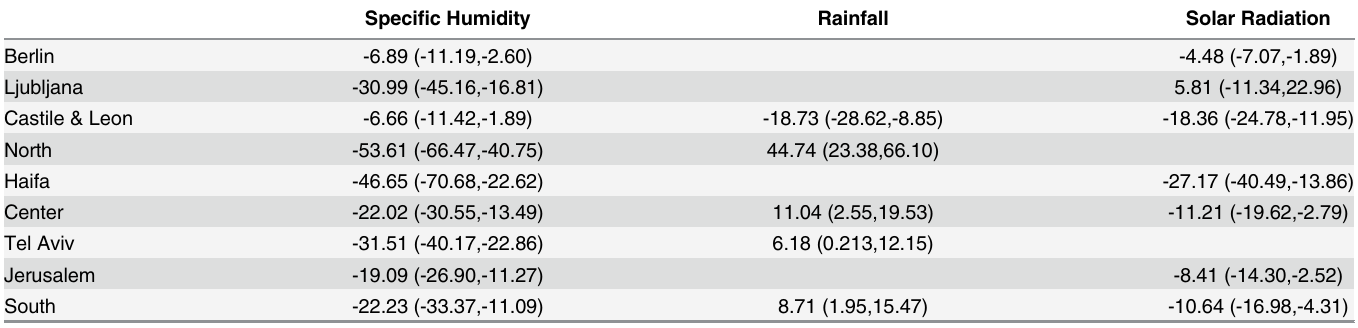
Table 3. Percentage change in influenza-associated ILI or ARI per 100,000 populations when one of the meteorological variables was increased from its median value by 10% of its range ( Δ x) during epidemic weeks (Model 1).